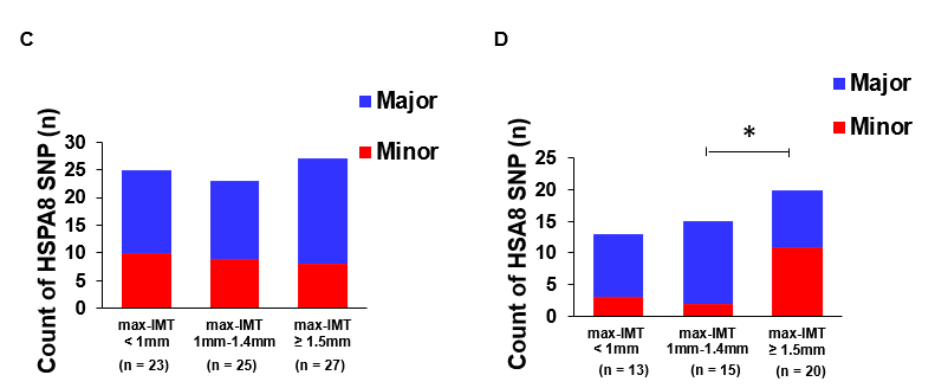
Figure 2. Sex differences in the association of Max-IMT and HSPA8 genotypes. ( A ) Comparison of Max-IMT between the HSPA8 genotypes stratified by sex. The middle bar represents the median and the upper/lower bars represent the 95% confidence interval. ( B – D ) HSPA8 genotype prevalence in the individual Max-IMT categories overall ( B ) and in female patients ( C ) and male patients ( D ). * p < 0.05 and ** p < 0.01. Max-IMT, maximum intima–media thickness; HSPA8 , heat shock 70 kDa protein 8.